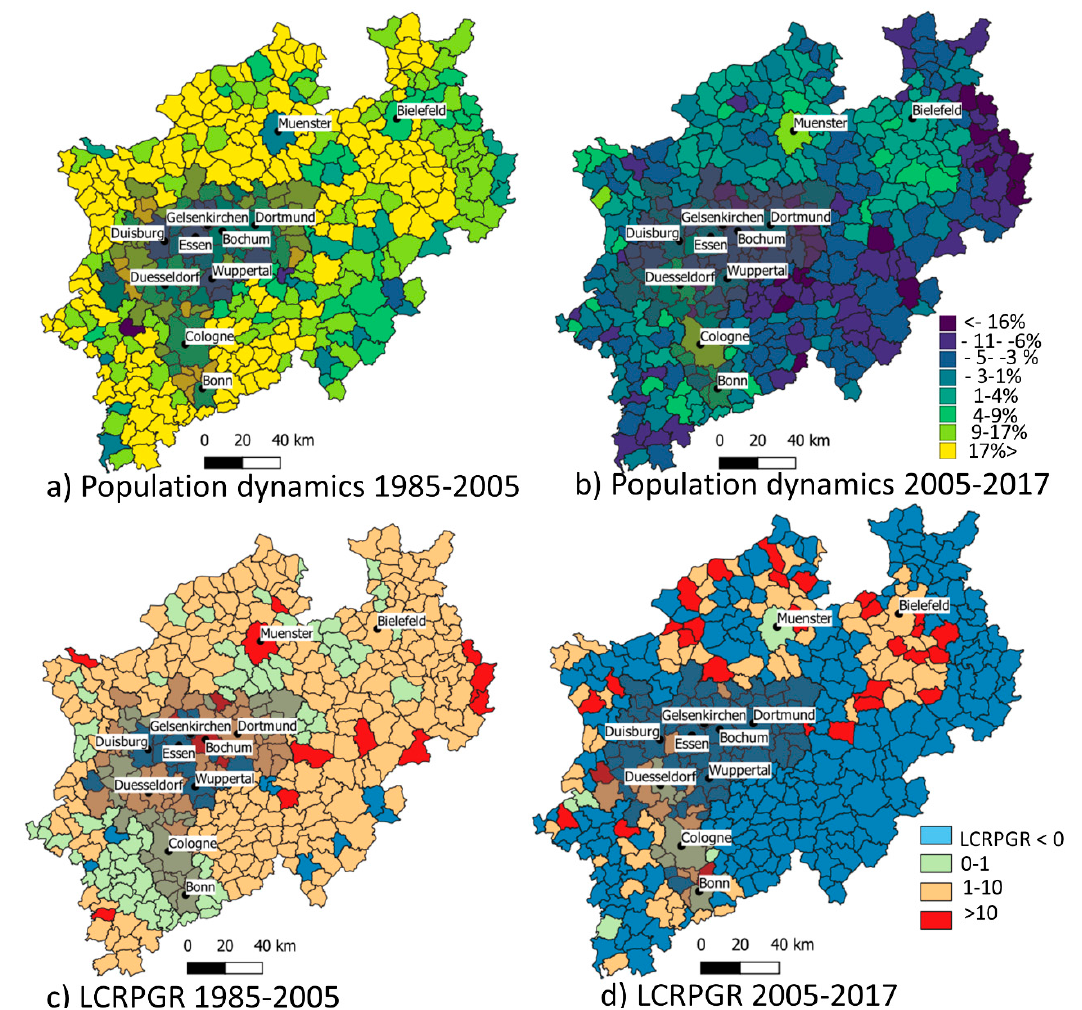
Figure 7. Changes in population in NRW between 1985–2005 ( a ) and between 2005–2017 ( b ) and LCRPGR for the period 1985–2005 ( c ) and 2005–2017 ( d ).